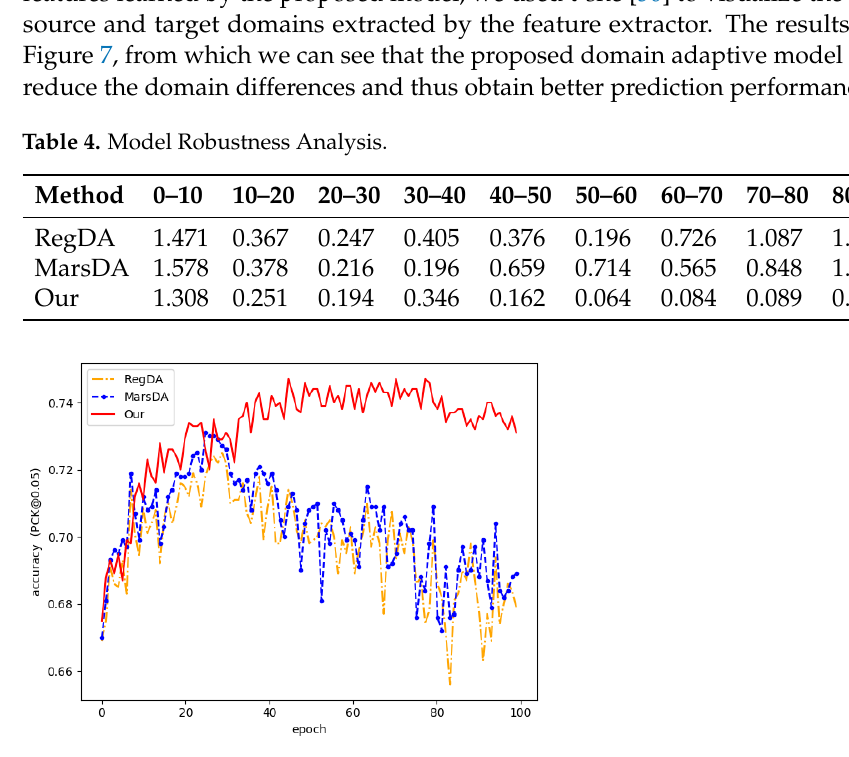
Figure 6. Accuracy of different adversarial training strategies during training.